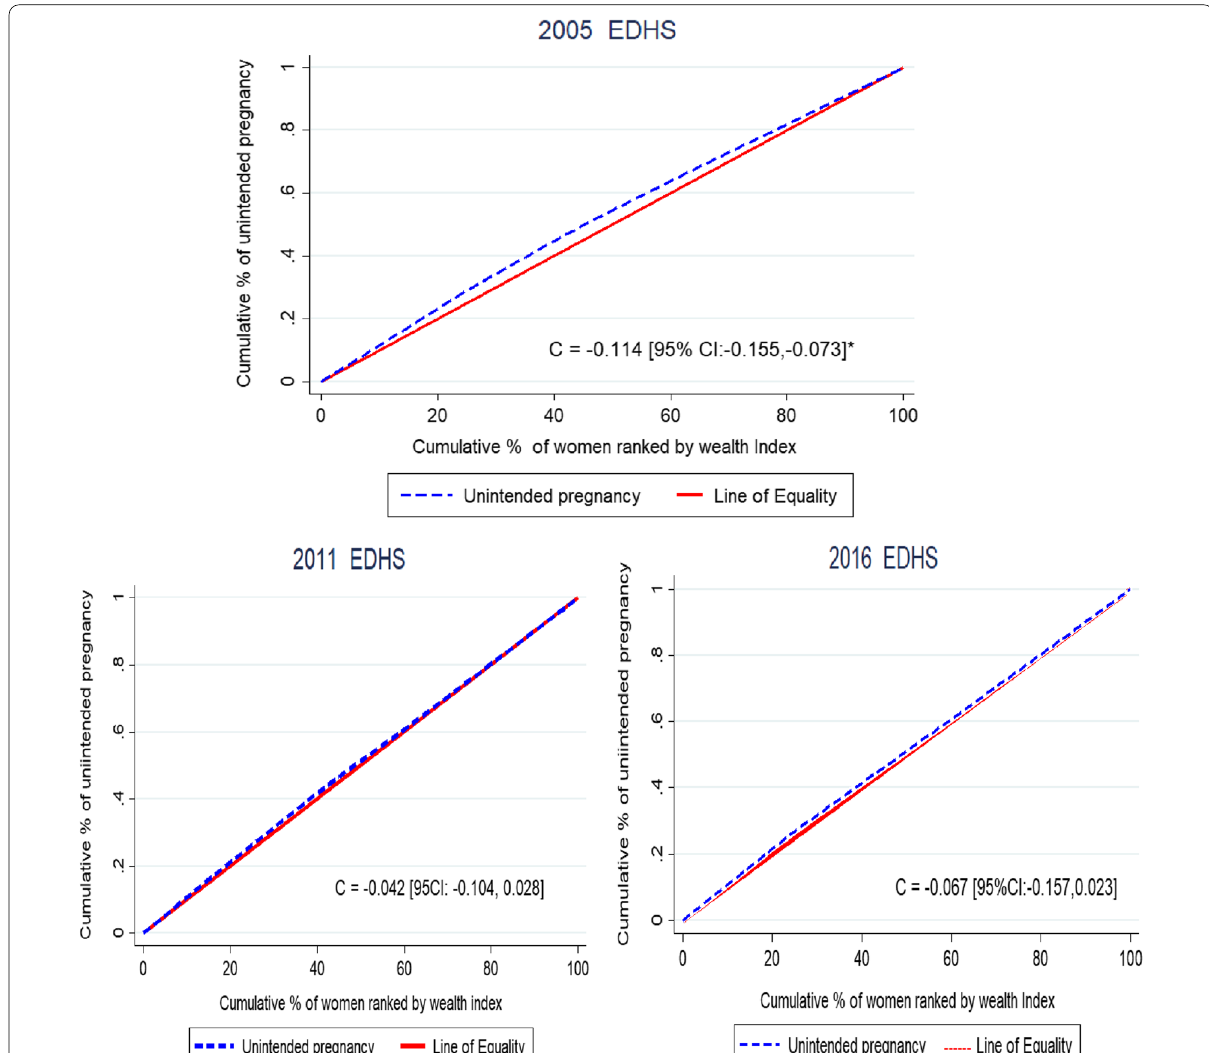
Fig. 2 The concentration graph shows wealth-related inequalities of unintended pregnancy in